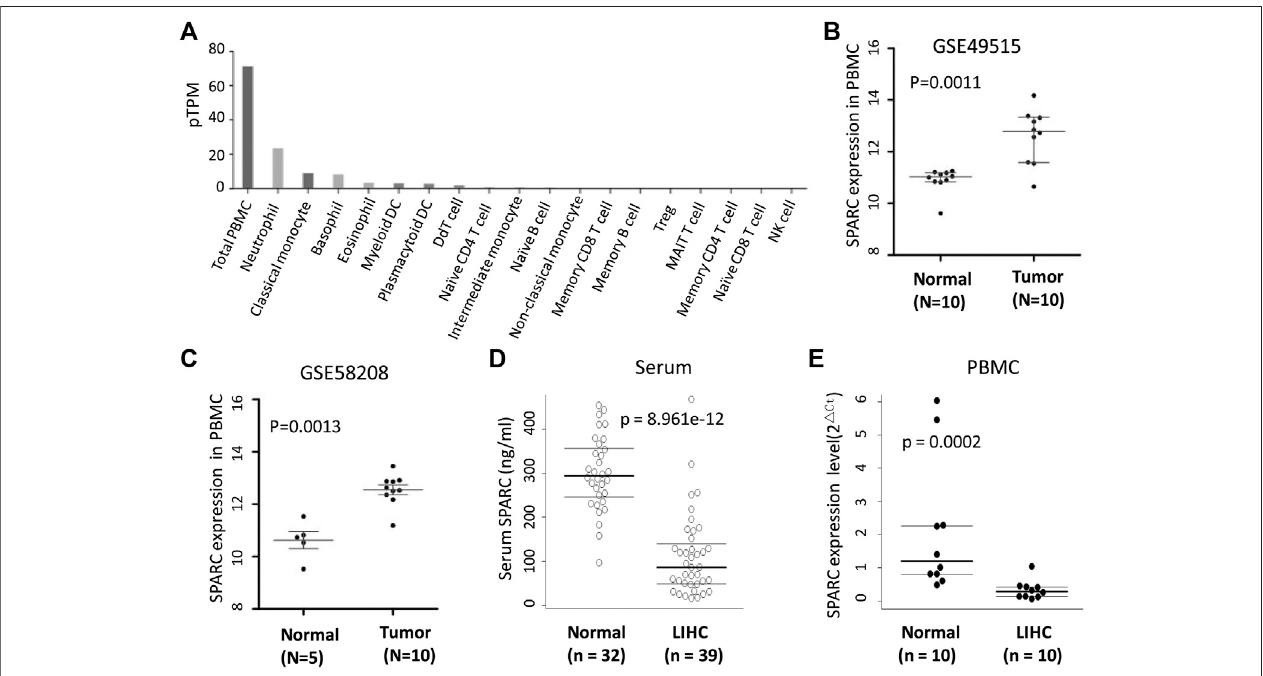
FIGURE 2 | SPARC levels in serum and PBMC from LIHC. (A) Human protein atlas (HPA) database showed the SPARC expression pro fi le in blood. (B, C) DifferentialSPARCmRNAexpression inPBMCbetweenLIHCandnormalcontrolsinGSE49515andGSE58208datasets. (D) SerumSPARCproteinlevelsinLIHCand healthy controls (HC). (E) SPARC mRNA expression levels in PBMC from our sample in this